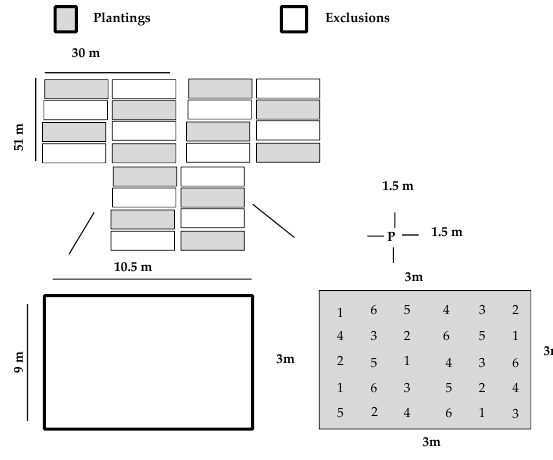
Figure 1. Experimental design.